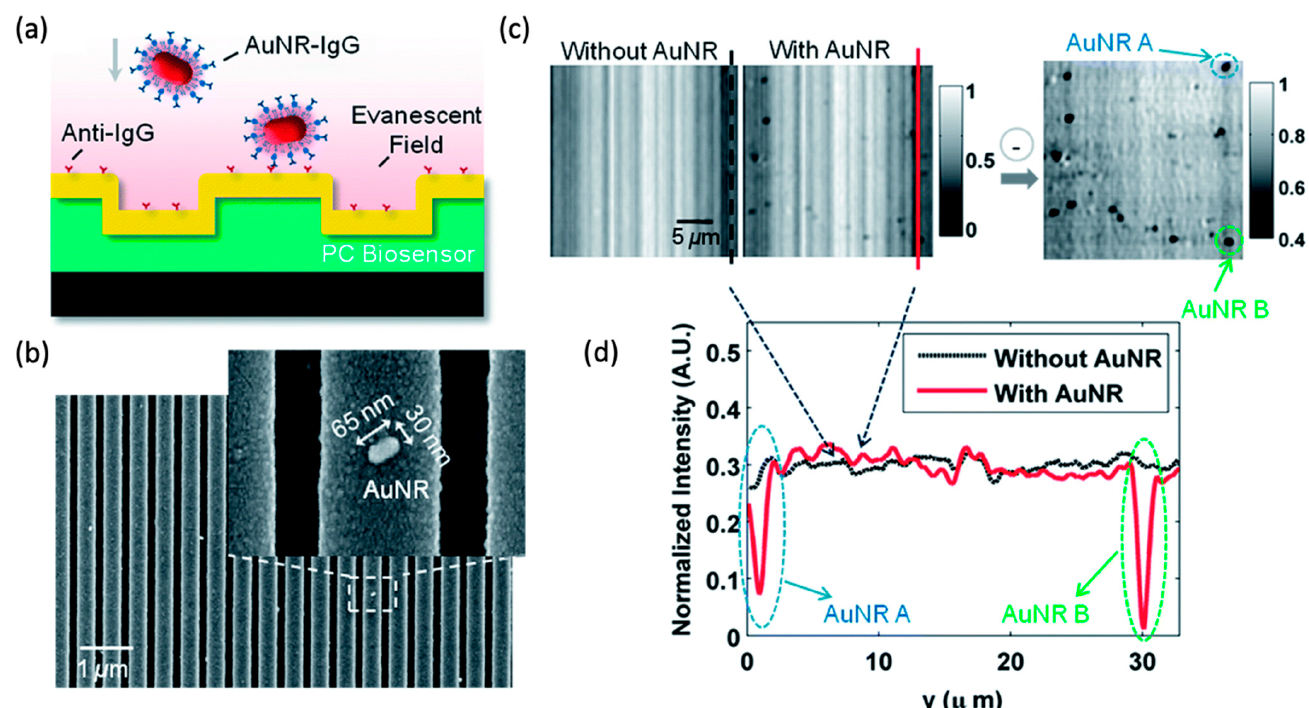
Figure 6. PCEM detection of protein–protein binding. ( a ) Schematic illustration of the attachment of AuNR–IgG (AuNR conjugated with SH-PEG–IgG) on a PC biosensor surface. ( b ) SEM images of AuNR–IgG attached to the PC biosensor surface. Inset: Zoomed-in image. ( c ) PCEM detected PIV images and the difference between without and with AuNR–IgG on the PC surface. ( d ) Two representative cross-section lines of the normalized intensity images with/without two AuNRs-IgG on the PC surface. Reprinted with permission from Ref. [76]. Copyright 2014 The Royal Society of Chemistry.